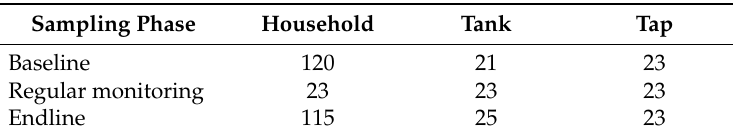
Table 2. Quantity of water samples at each phase of